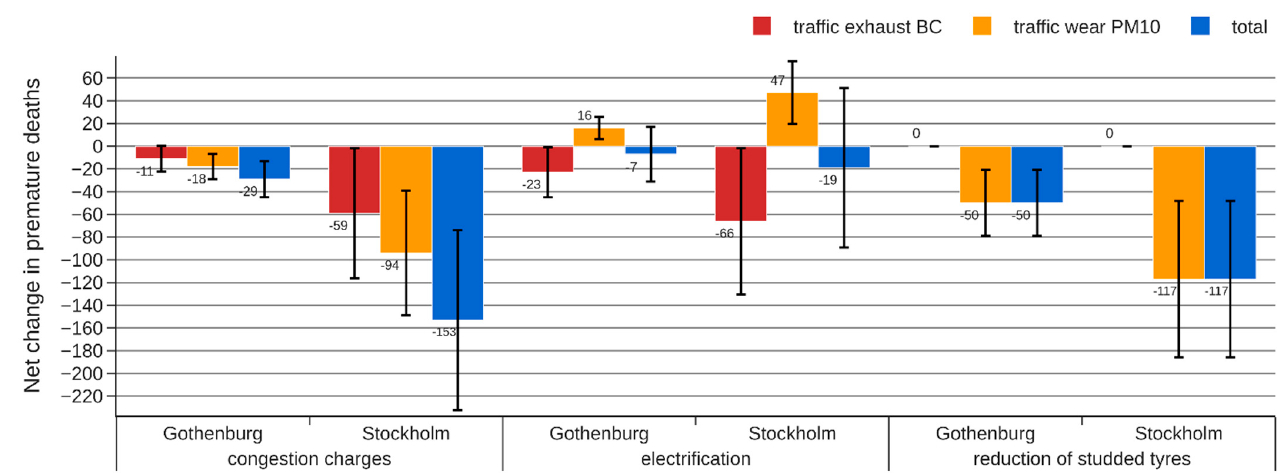
Figure 8. Estimated change in number of premature deaths for each of the abatement strategies following approach C (separation by source category and distance). The error bars represent a 95% CI.